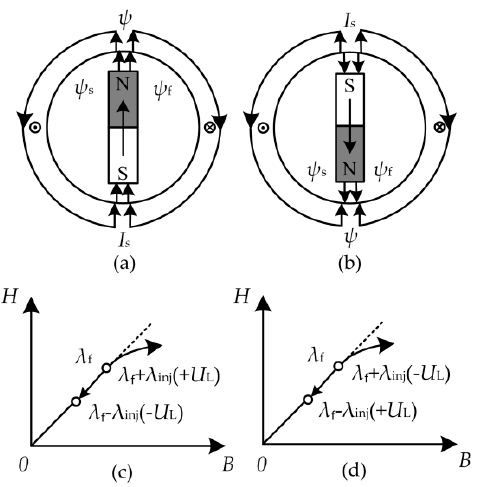
Figure 9. ( a ), ( b ) represent the distribution of the air gap magnetic field; ( c ), ( d ) represent the principle Figure 9. ( a , b ) represent the distribution of the air gap magnetic field; ( c , d ) represent the principle of of rotor pole polarity. rotor pole